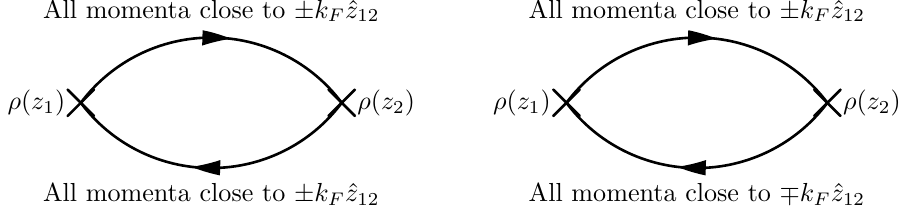
Figure 4: These two diagrams correspond to the two dominant classes of momentum config- − z urations for large separations z . Here we imagine an infinite series of boson exchanges 2 1 attached in all possible combinations on the upper and lower lines. Since the boson carries momentum much smaller than k , this will still keep the fermion momenta in the same patch F along the upper and lower lines. The two lines however need not belong to the same patch. Since only two opposite patches dominate in the large separation limit the upper and lower lines are either in the same (a) or opposite patches (b). In the former case the dominant exter- nal momentum is small compared to k , in the latter case the dominant external momentum F ˆ z is close to ± 2 k F 12